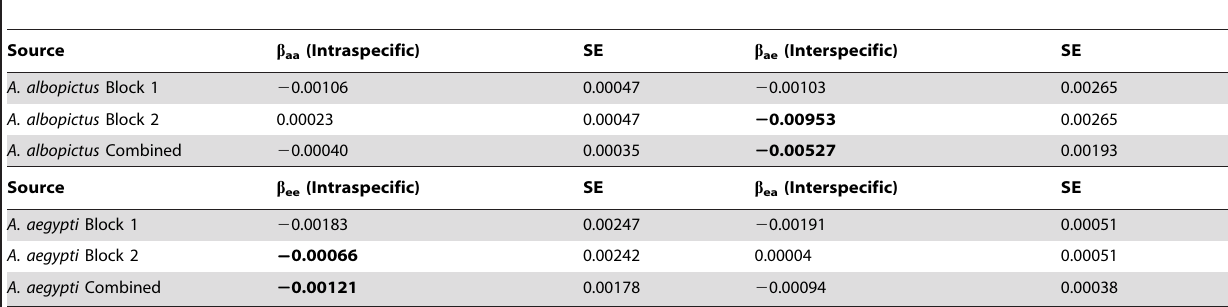
Table 5. Estimates of intra- and interspecific competitive effects for the pairwise response surface experiments Aedes albopictus vs. Aedes aegypti